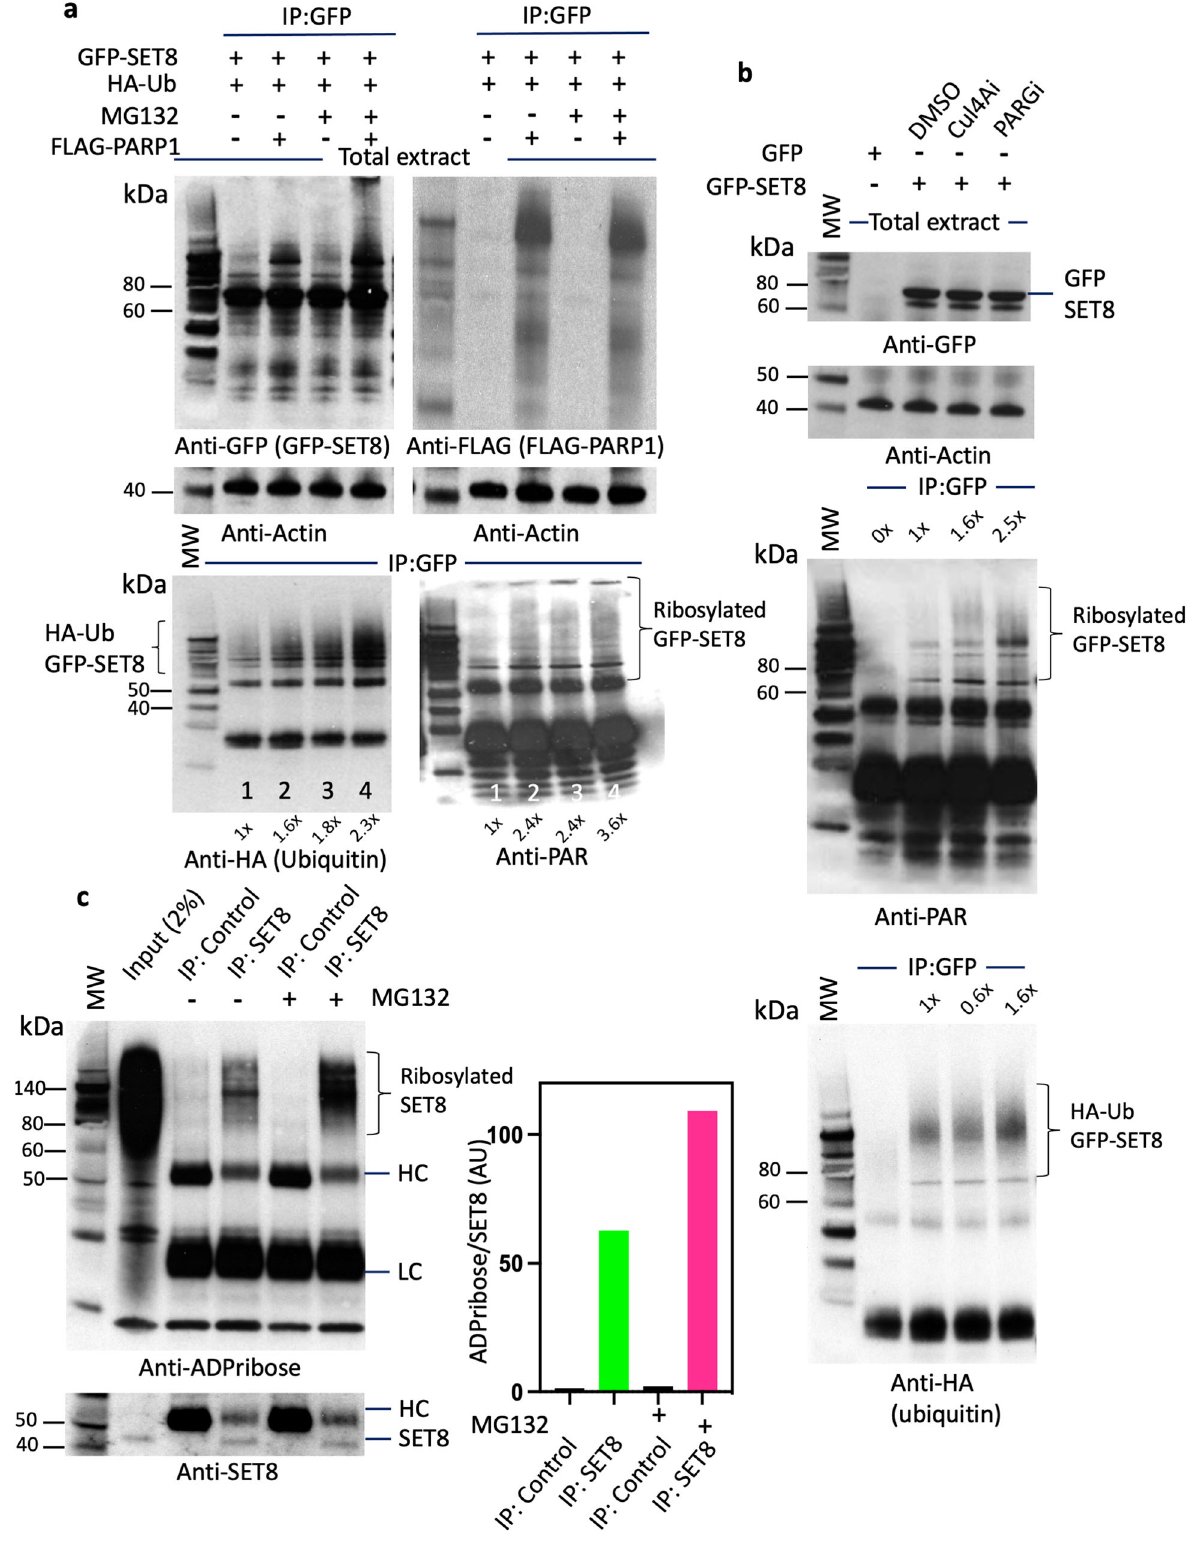
(Fig. 4b). Therefore, it is plausible that the lysine residues in the disordered domain are crucial in maintaining SET8 enzyme levels in cell. We next pursued half-life studies of endogenous SET8 by PARP1 depletion using siPARP1. Half-life of endogenous SET8 in control cells with siGFP transfection was 0.74 h compared to 1.47 h in PARP1 knockdown cells (Supplementary Fig. 17a,